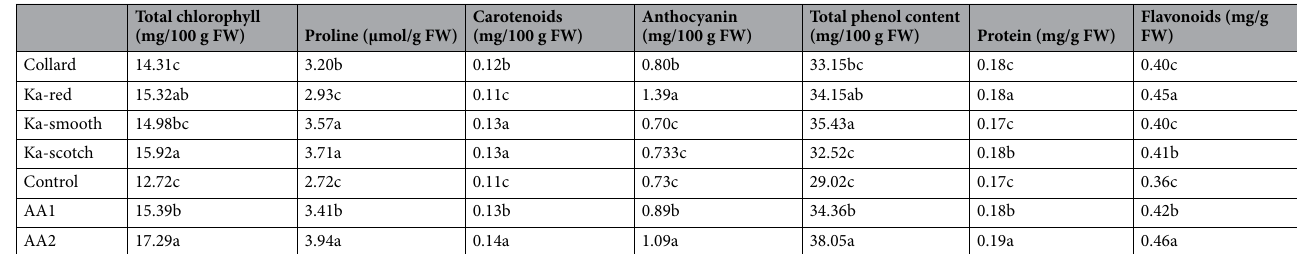
Total chlorophyll (mg/100 g